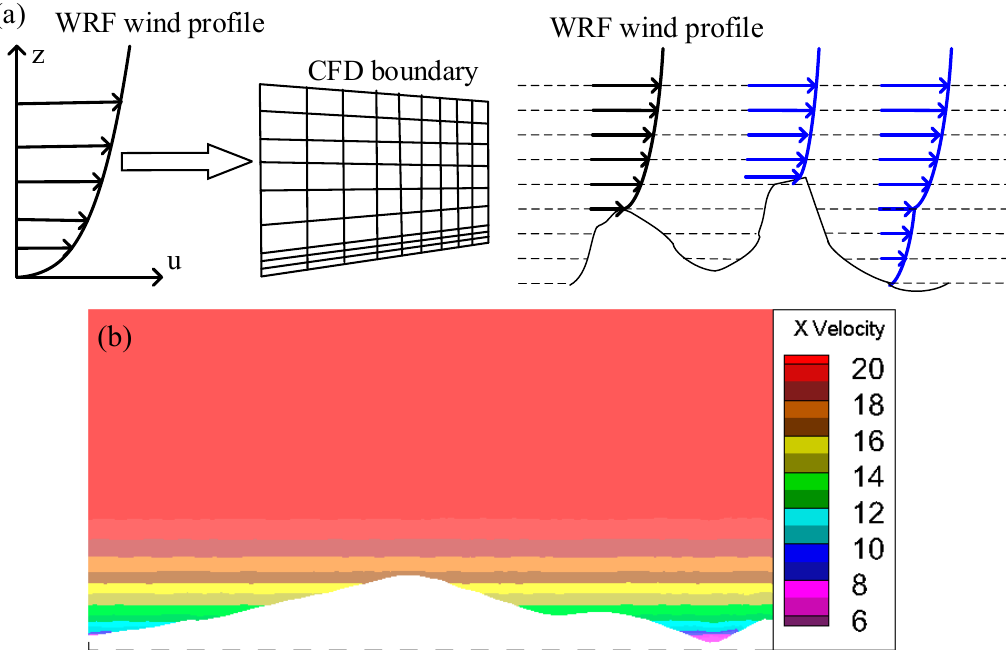
Figure 3. Extrapolation coupling method: ( a ) Diagram of the extrapolation method: A single WRF profile is imposed on an entire CFD boundary, and WRF wind data are extrapolated in the CFD grid points below or above the WRF profile. ( b ) Wind velocity (m / s) on a CFD boundary using extrapolation, with the horizontal axis ( x ) showing the width (0–4 km) and the vertical axis ( z ) showing the height (0–2 km).